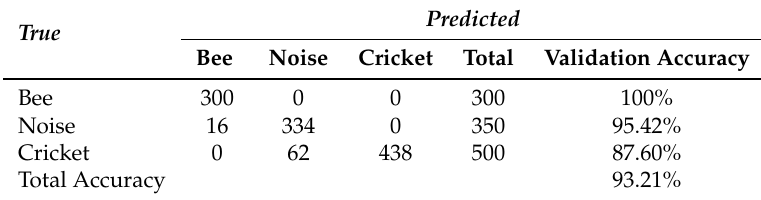
Table A9. Confusion matrix for random forests with no feature scaling on BUZZ1 validation dataset.